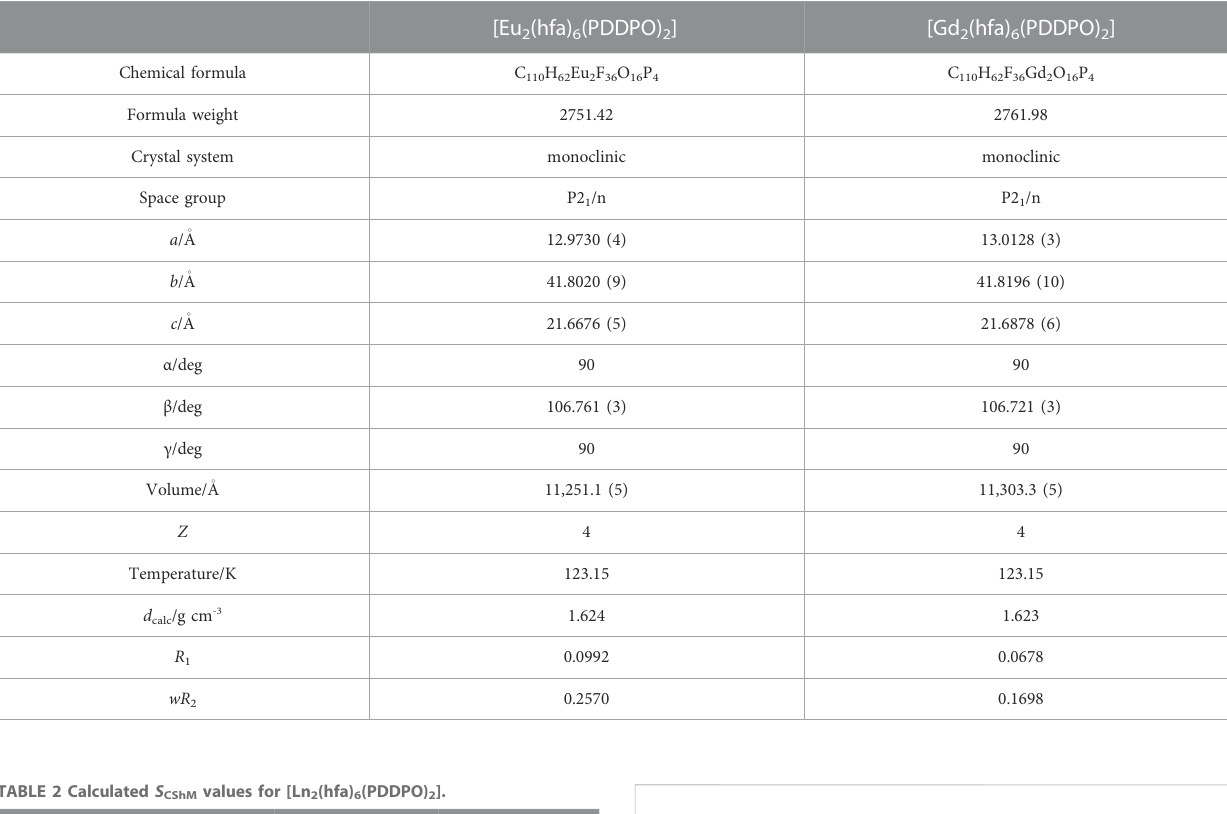
TABLE 1 Crystallographic data for [Ln 2 (hfa) 6 (PDDPO) 2 ].